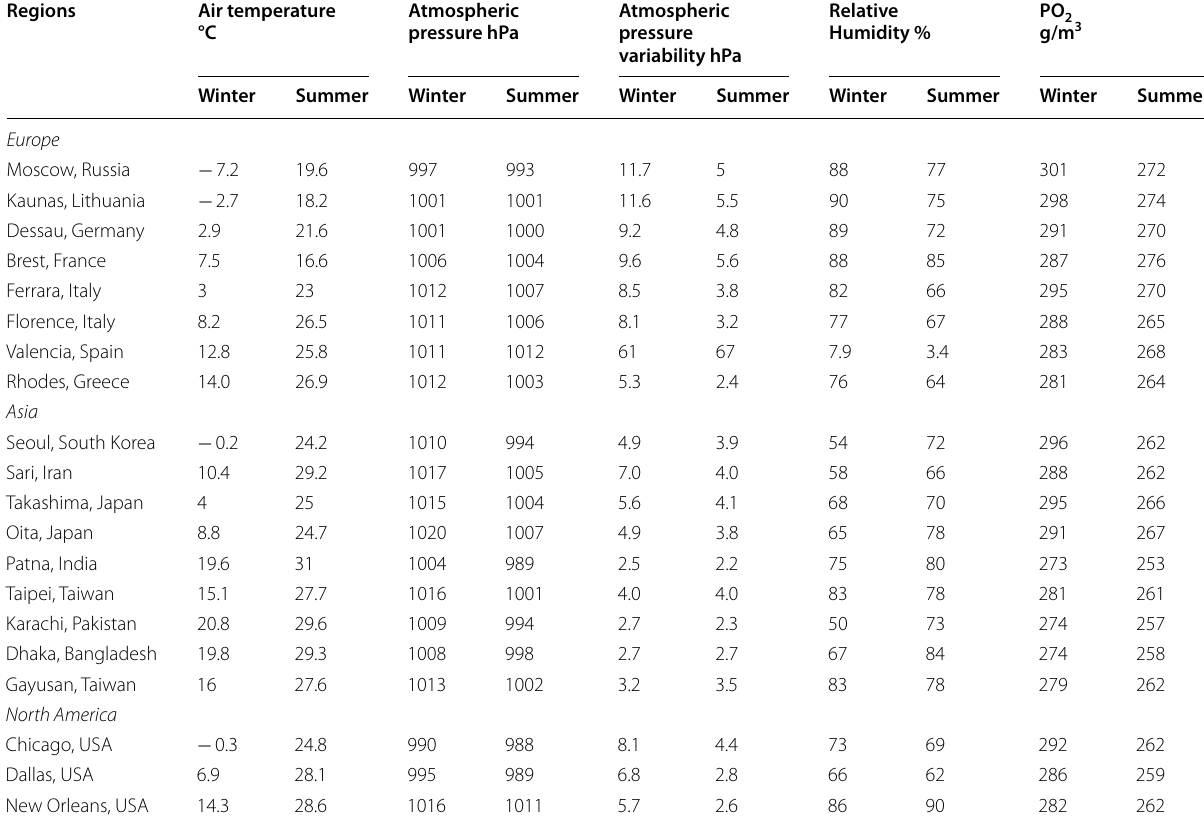
Table 2 Seasonal dynamics of meteorological factors in the studied regions (regions are arranged in decreasing order of geographical latitude)